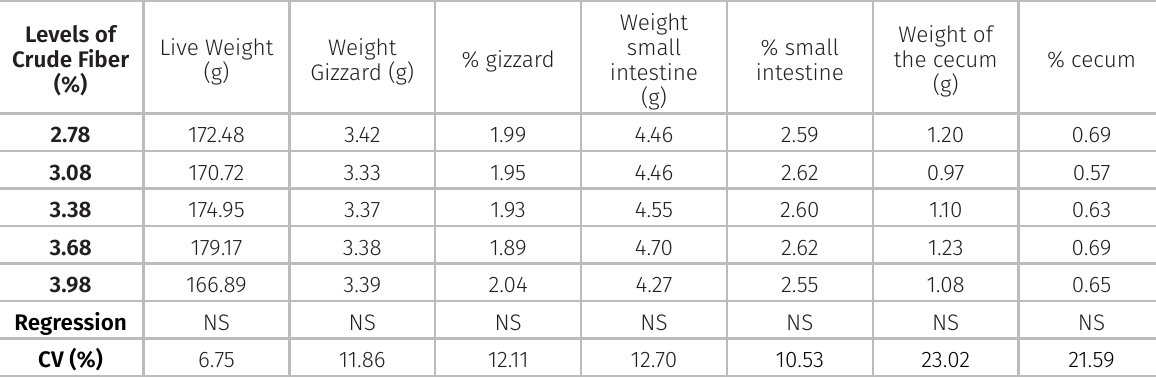
Table V. Live weight (g), absolute weight of the gizzard(g), relative weight of the gizzard(%), absolute weight of the small intestine (g), relative weight of the small intestine (% small intestine), absolute weight of the cecum